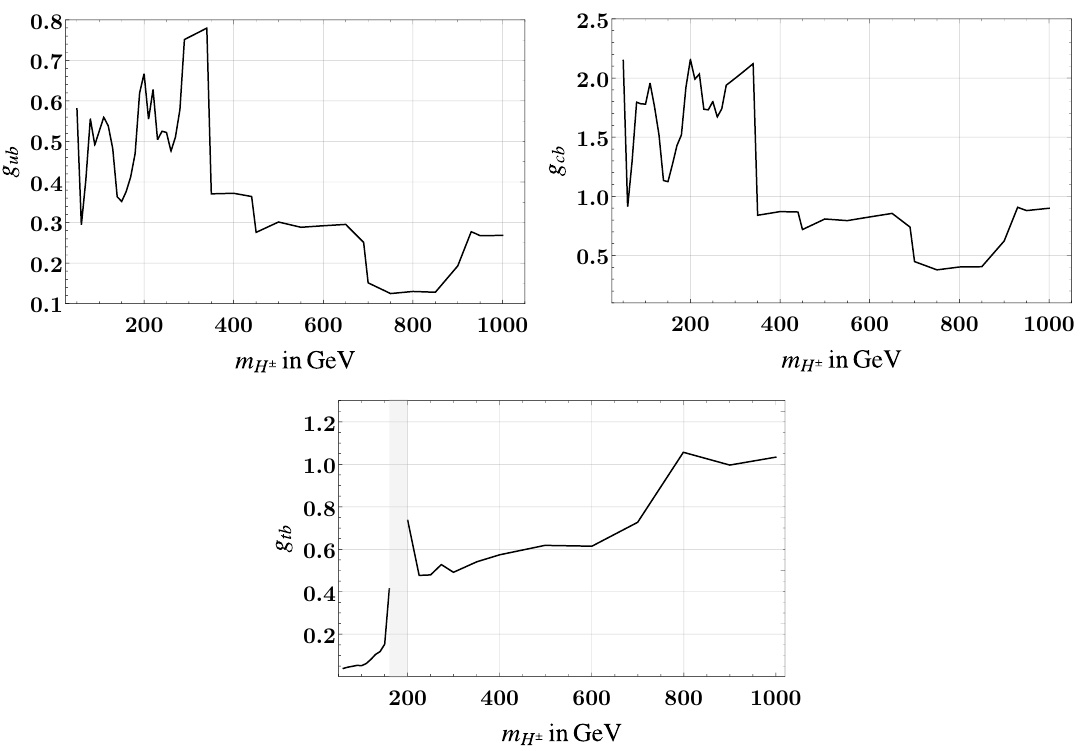
Figure 14 . Combined constraints on charged Higgs couplings in the limit where the coupling g ub (left upper panel), g (right upper panel) or g (lower panel) dominates. cb tb